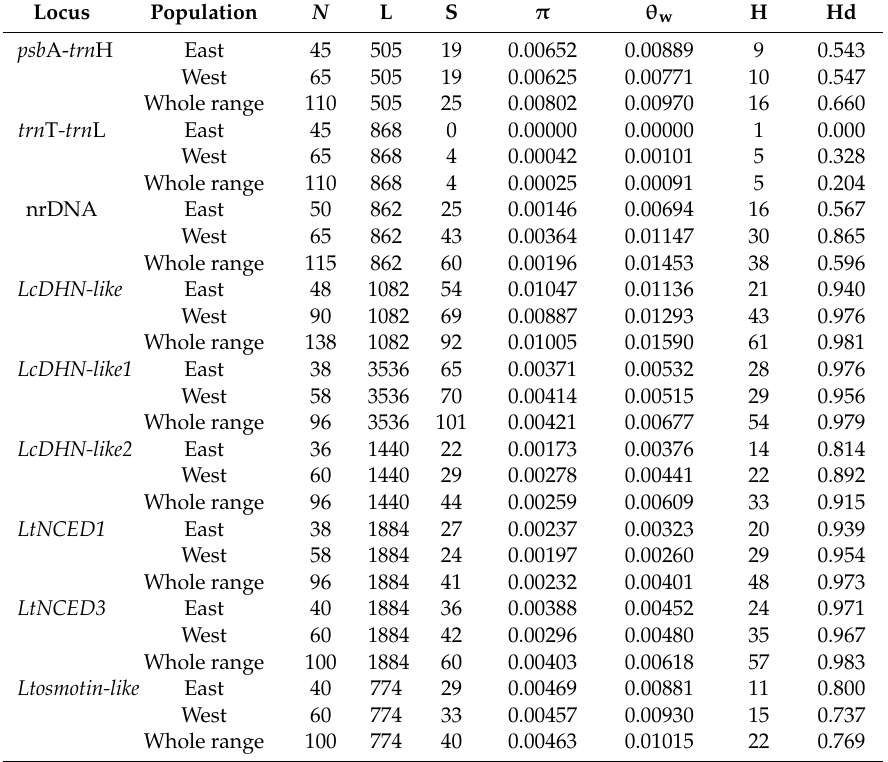
Table 4. Summary statistics of sequence diversity of L. chinense .